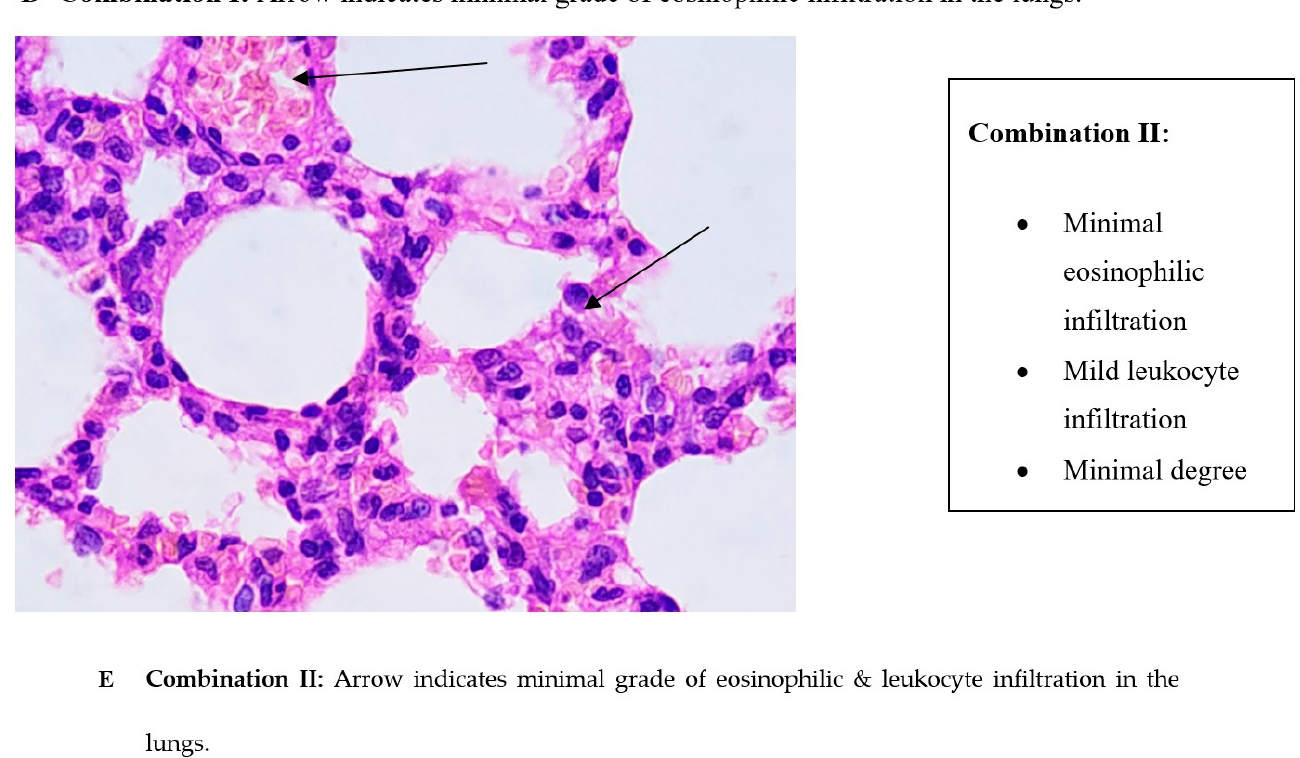
Figure 3. Effect of treatment combination on OVA-induced alteration in lung histology of rats